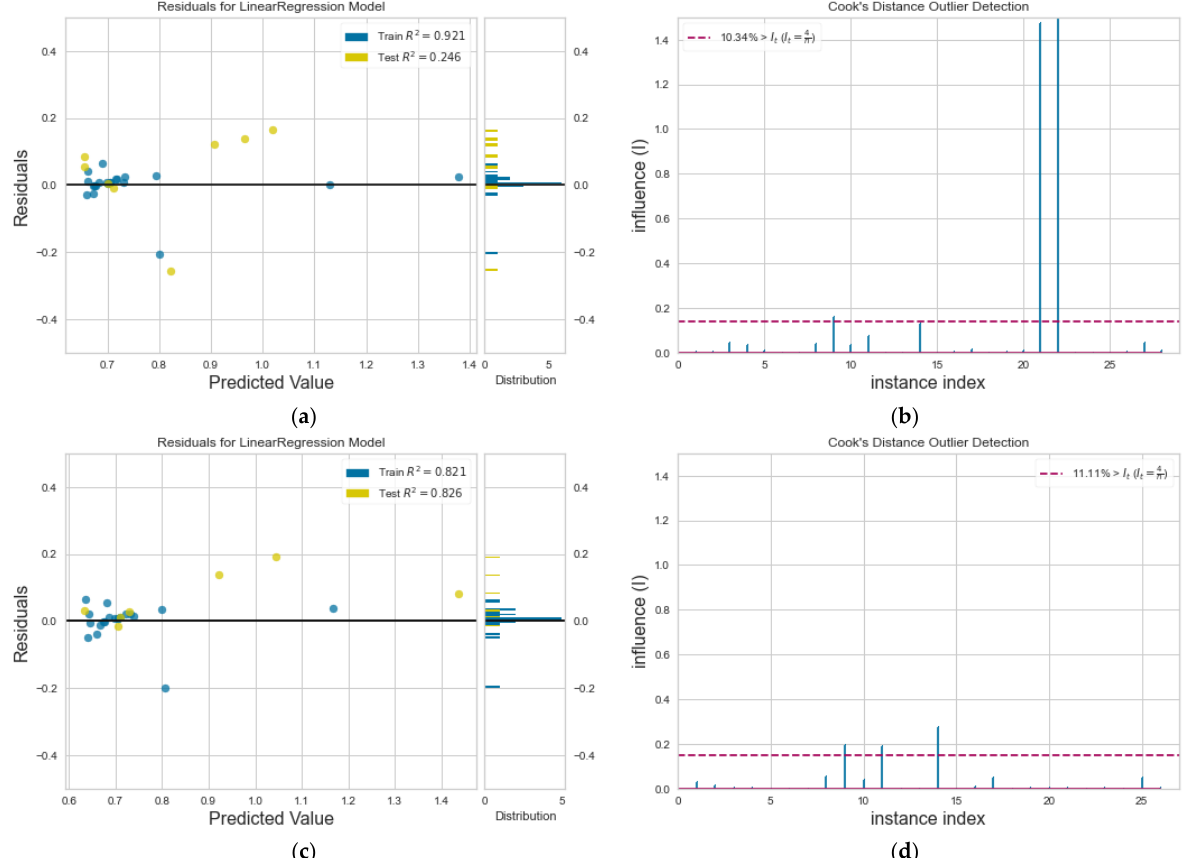
Figure 8. ( a ) Residuals plot and ( b ) Cook’s distance for k , and, after the removal of outliers from the dataset, ( c ) new residuals plot and ( d ) new Cook’s distance.